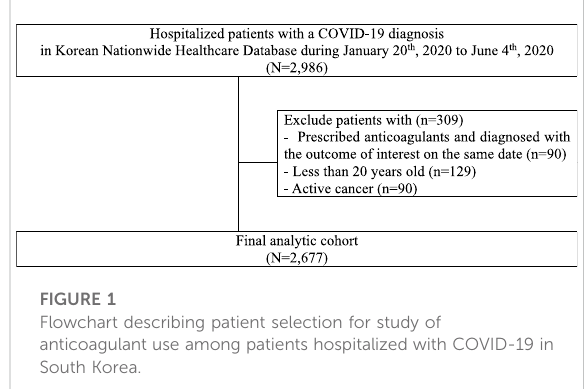
FIGURE 1 Flowchart describing patient selection for study of anticoagulant use among patients hospitalized with COVID-19 in South